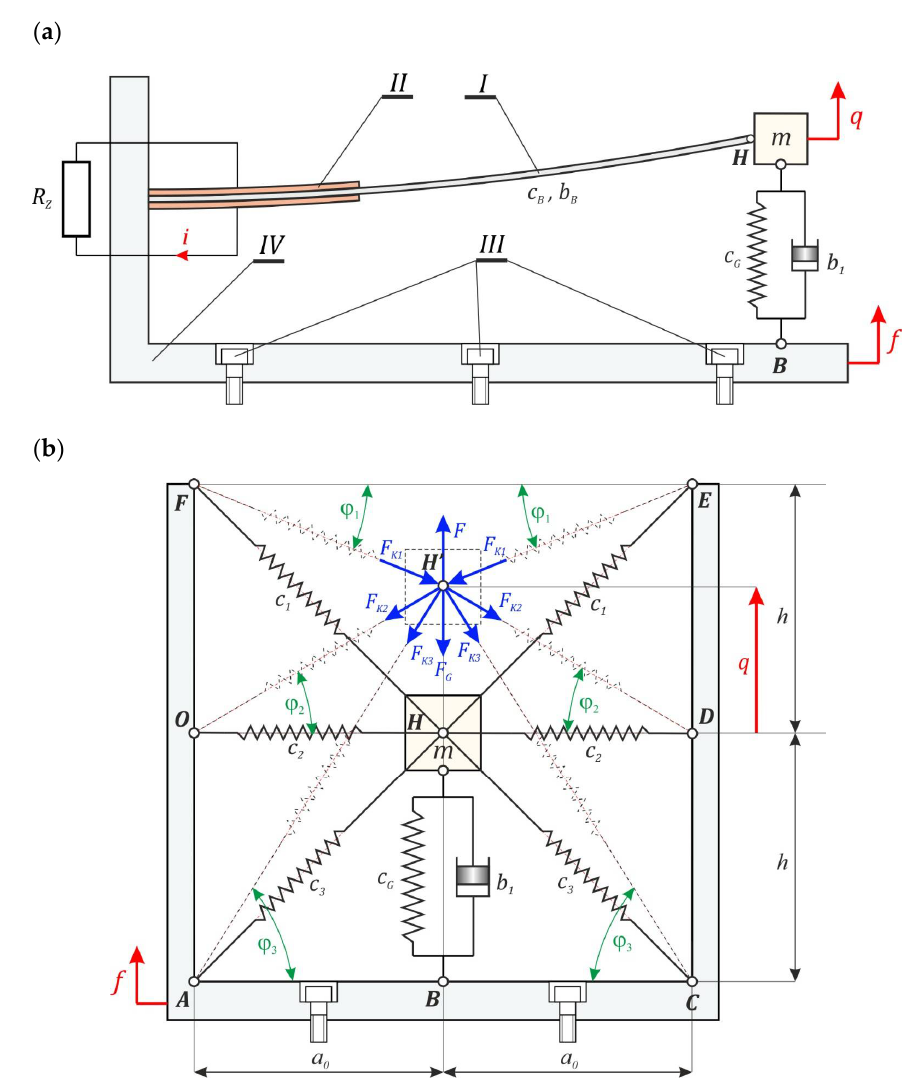
Figure 1. Schematic diagrams of the energy harvesting system with a star-shaped structure of elastic elements, visible from the direction: ( a ) perpendicular to the axis of the flexible beam, ( b ) parallel to the axis of the flexible beam. Geometrical and system parameters as well as the resulting force with their components are denoted in the picture.